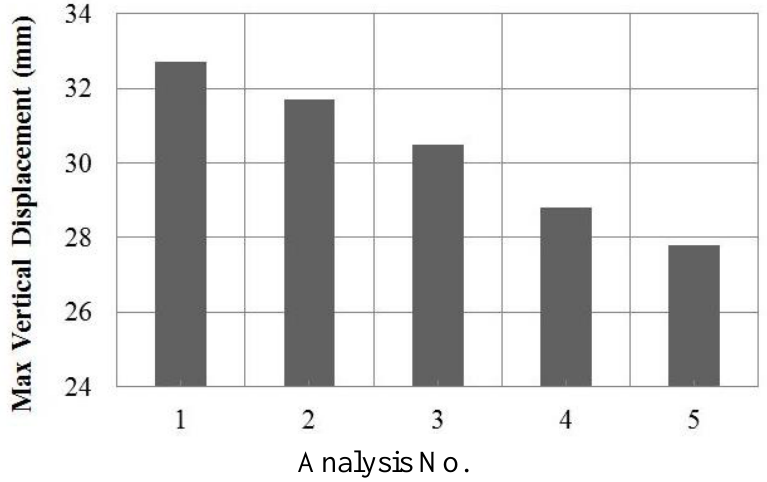
Fig. 7. Maximum vertical displacement of tunnel crown lining for different analyses